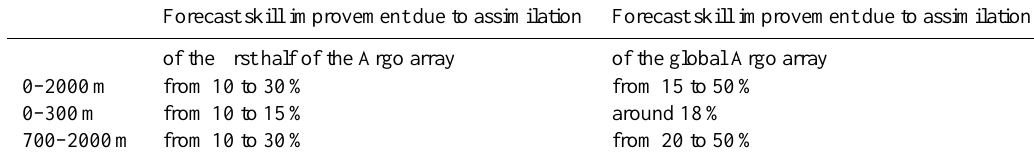
Table 2. Temperature forecast skill improvement derived from the reduction of the RMS temperature innovations. Forecast skill improvement due to assimilation